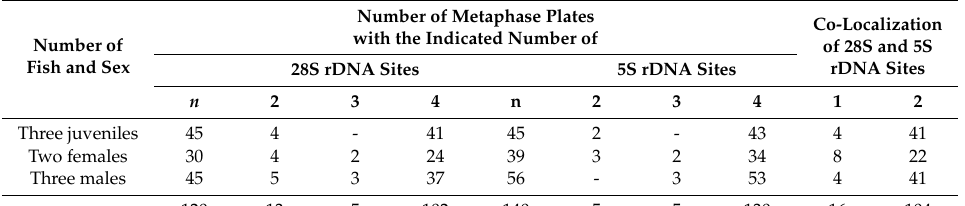
Table 2. The frequency of 28S and 5S rDNA hybridization sites in the karyotype of Chondrostoma nasus . Number of analyzed metaphase plates = n .